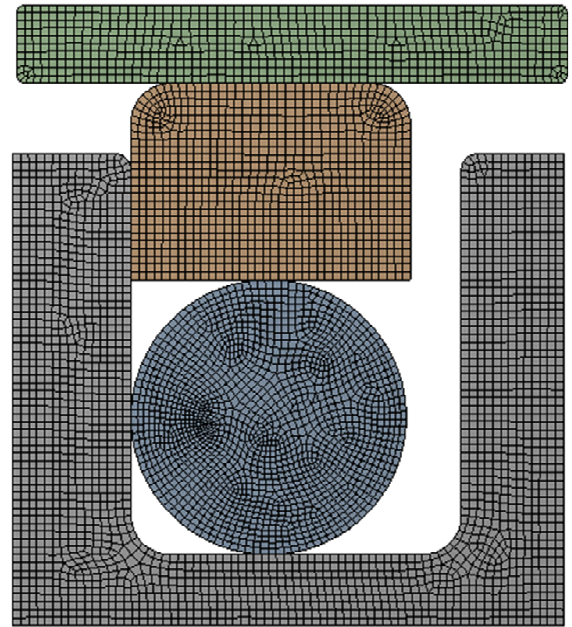
Figure 2. Combination seal ring contact analysis settings.